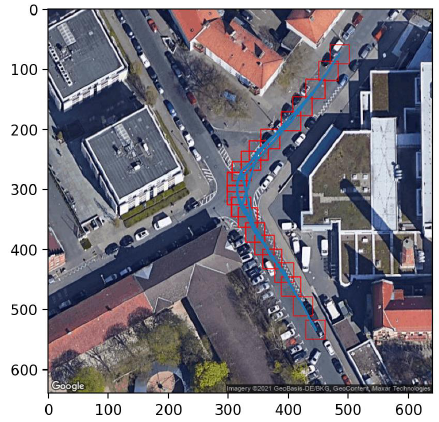
Figure 3. An example of the grid sequence aligned with a vehicle’s speed sequence. As denoted by the red bounding boxes, each step is a 32 × 32 –pixel grid with the current step’s GPS position located in the